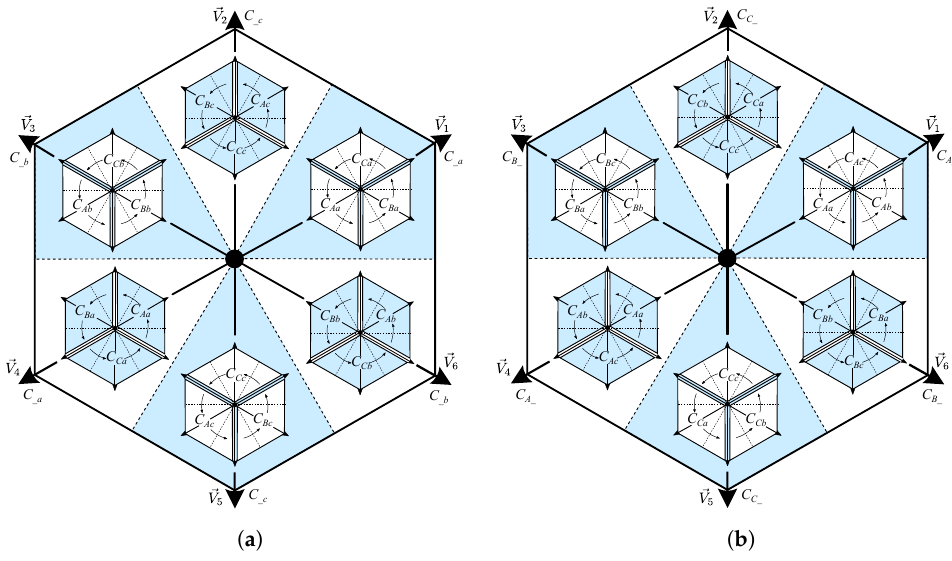
Figure 19. Choice of capacitor. ( a ) when d 0_ in is greater than d 0_ out . ( b ) when d 0_ out is greater than d 0_ in